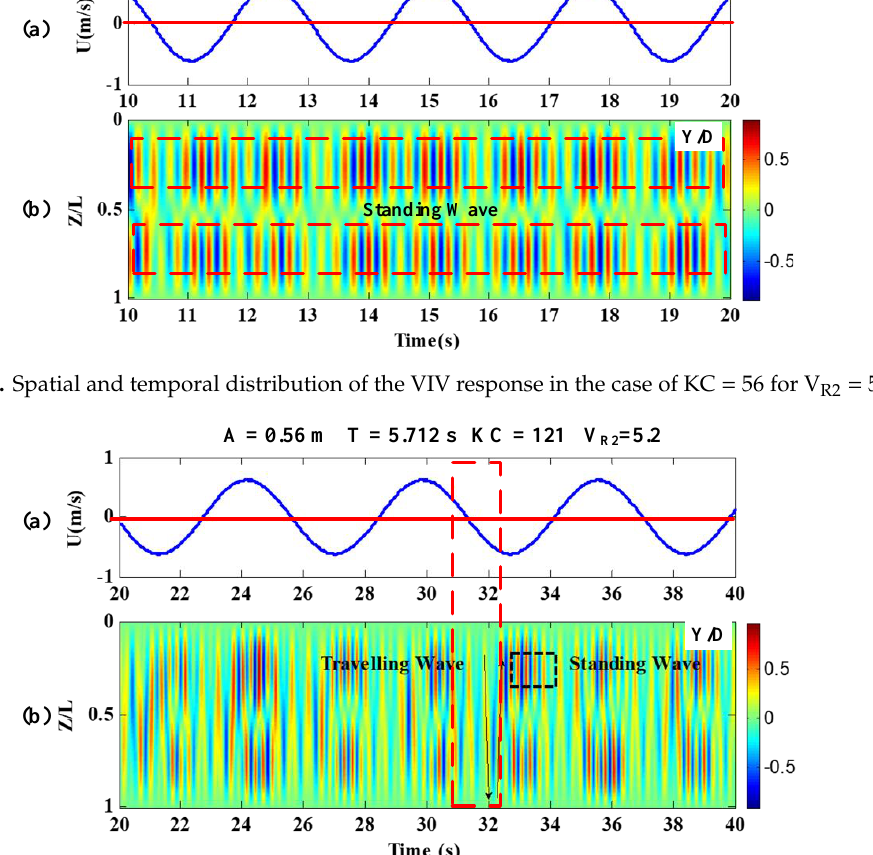
Figure 9. The spatial and temporal distribution of the VIV response in the case of KC = 121 for V R2 = 5.2.